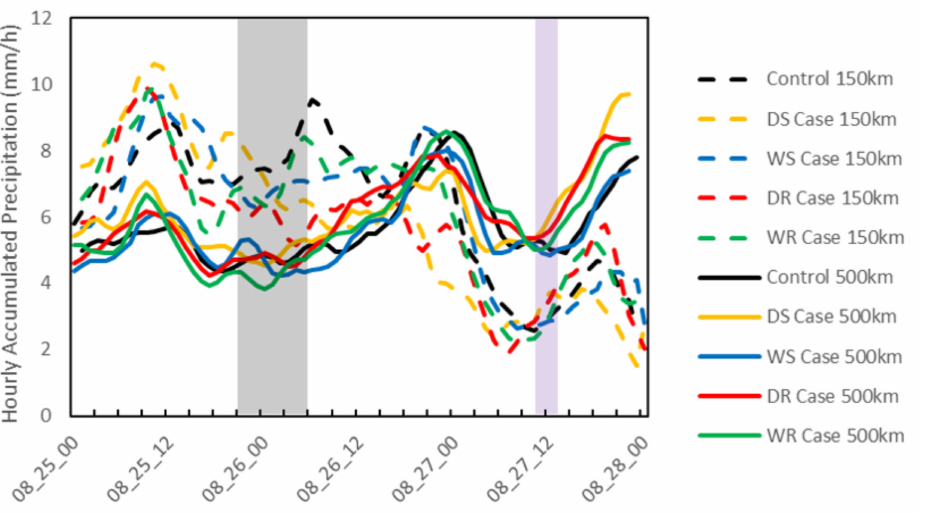
Figure 9. Hourly precipitation accumulation averaged for the region within 150 km (dashed line) and 500 km of the storm center (solid line) for non-zero grid